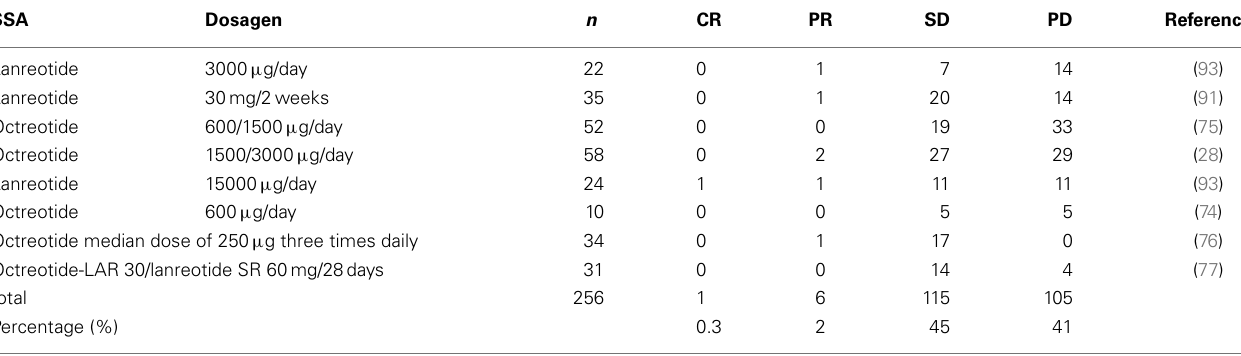
Table 4 |Anti-proliferative effect of somatostatin analogues in patients with progressive